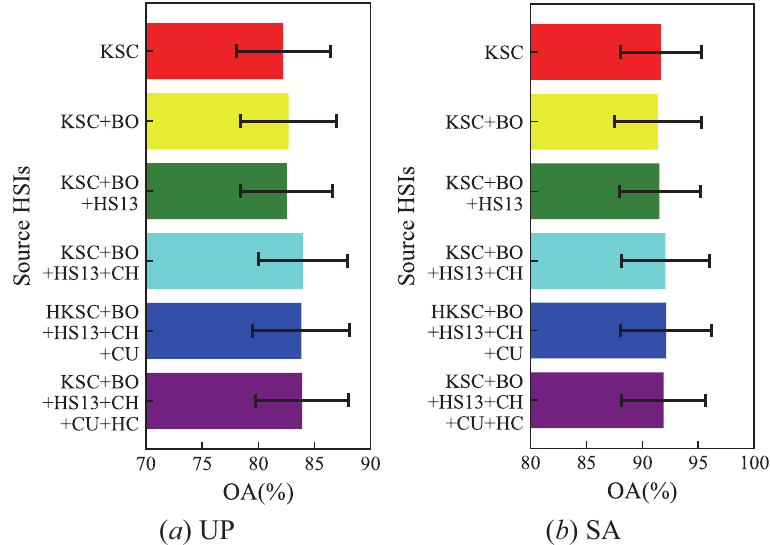
Figure 15. The influence of different source HSIs on the classification